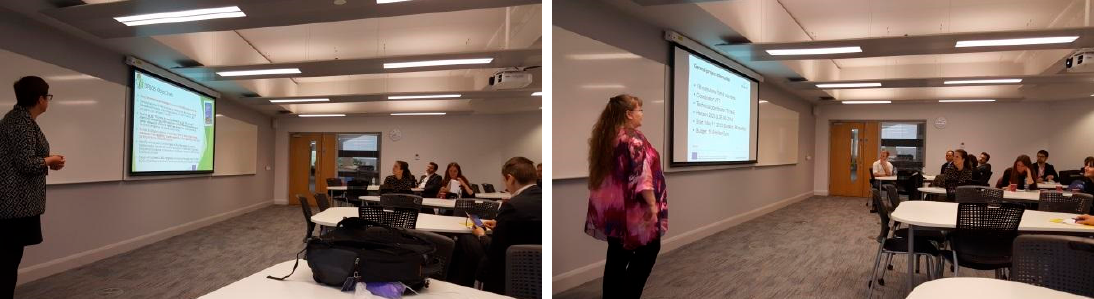
Figure 2. Pictures from the